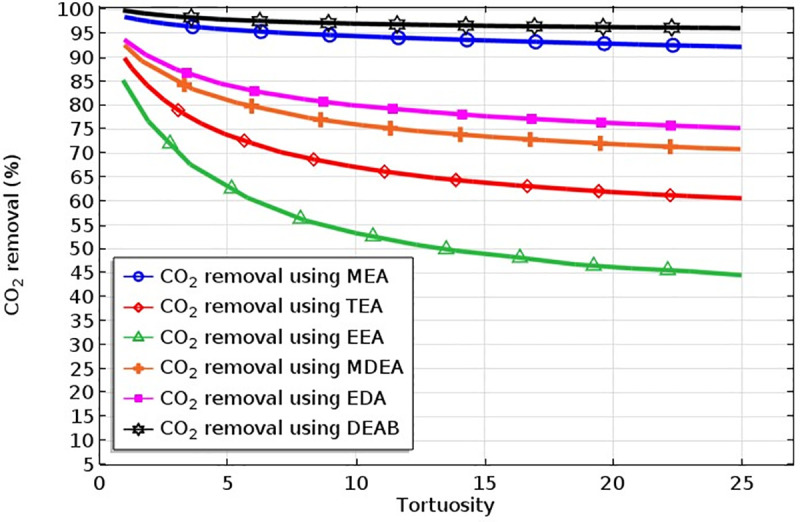
Influence of the membrane tortuosity parameter on the CO2 removal using MEA, TEA, EEA, EDA, MDEA and DEAB absorbents.